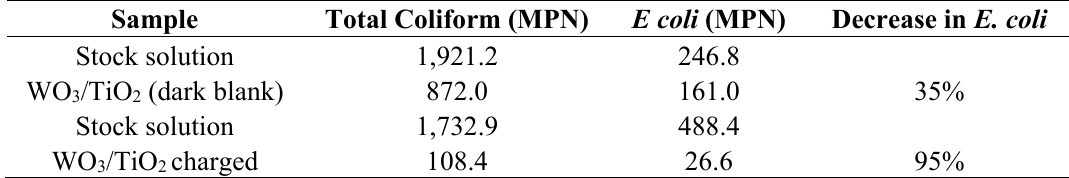
Table 3. Coliform counts after exposure to TiO 2 /WO 3 without and with pre-charging for 2 h. (MPN = most probable number of